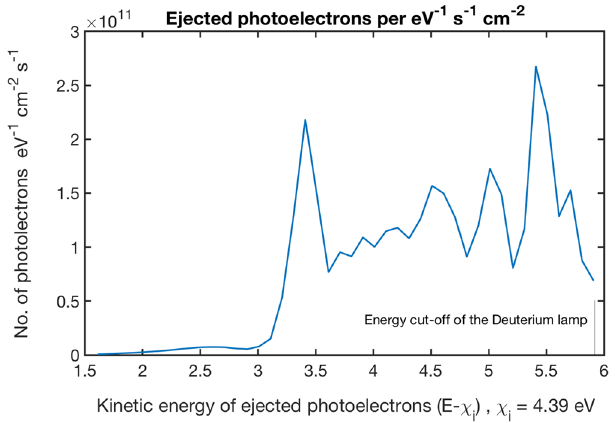
Figure 6. Raman spectra at several locations in the carbon fibre. The red spectrum is similar to the diamond like carbon spectrum and obtained in the main body of the fibre 19 . The black spectra have been obtained on the crystallites, at two different